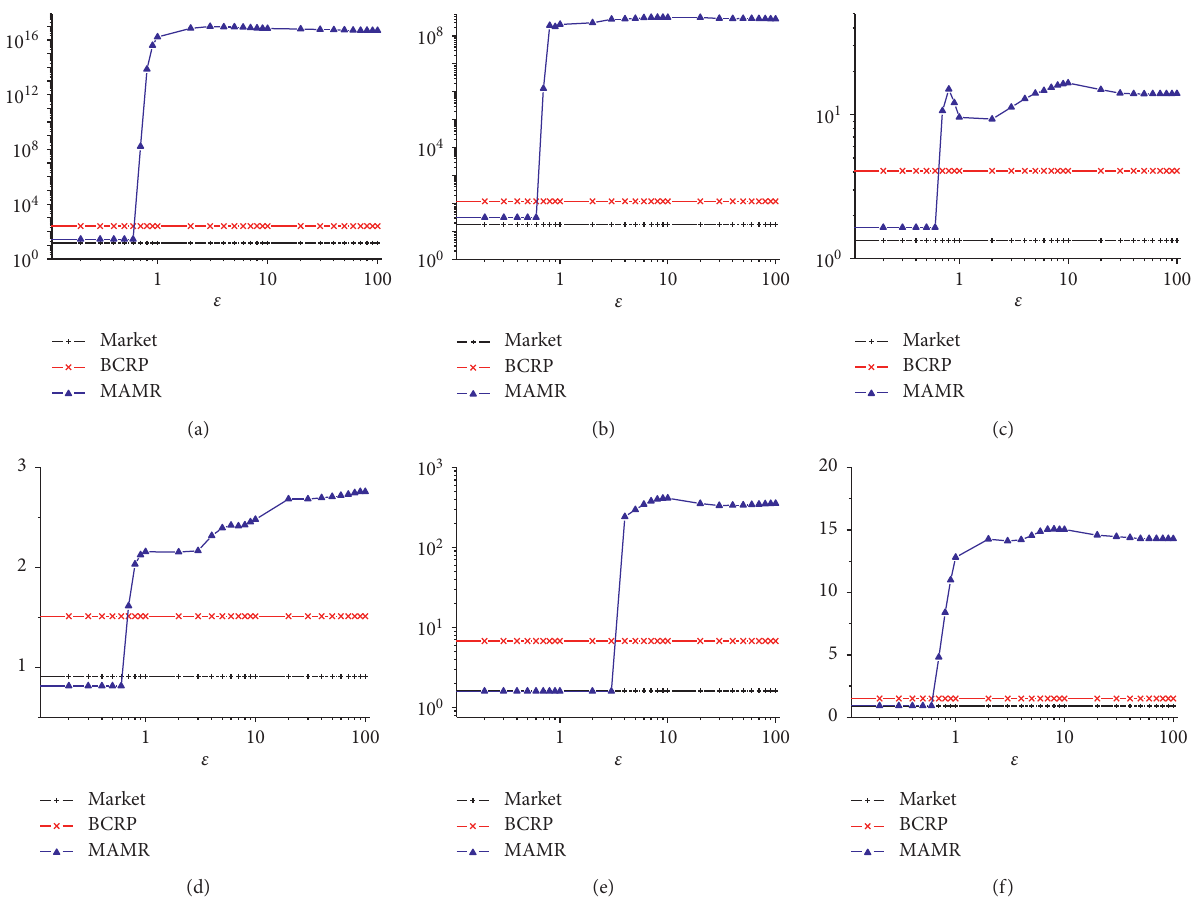
� 3, and C � 100. (a) NYSE(O). (b) NYSE(N). (c) SP500. 1 2